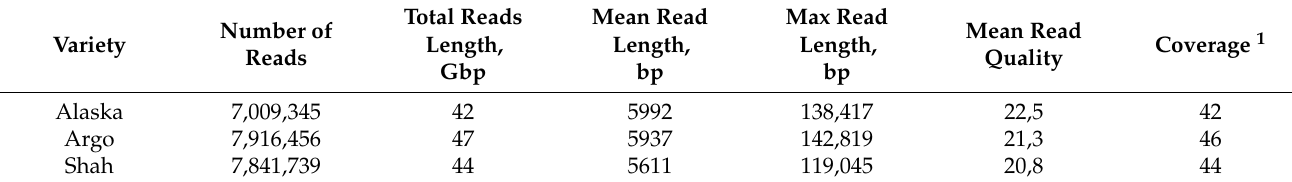
Table 2. Summary of the quality table of the obtained